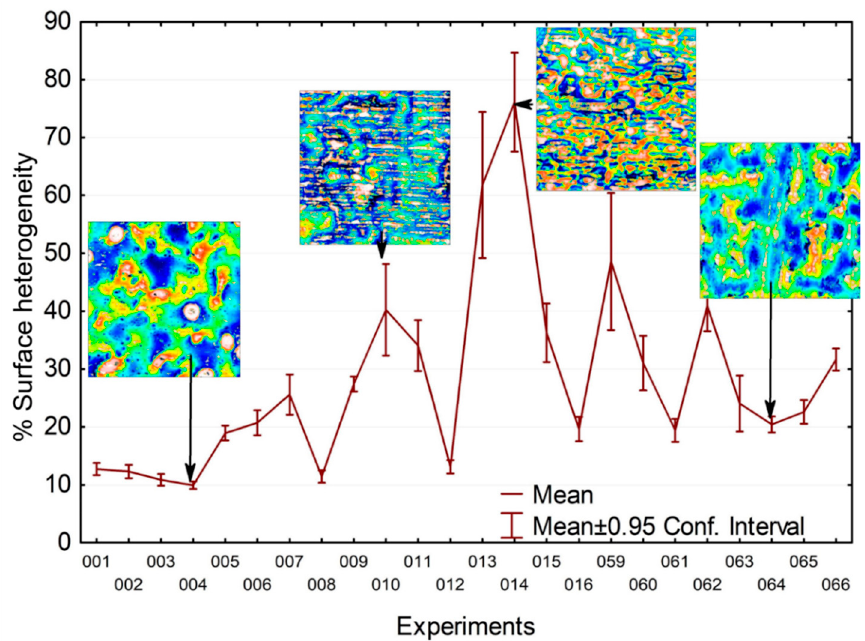
Figure 14. A graph of the percentage of surface heterogeneity for all samples of the experimental design showed in Table 1.